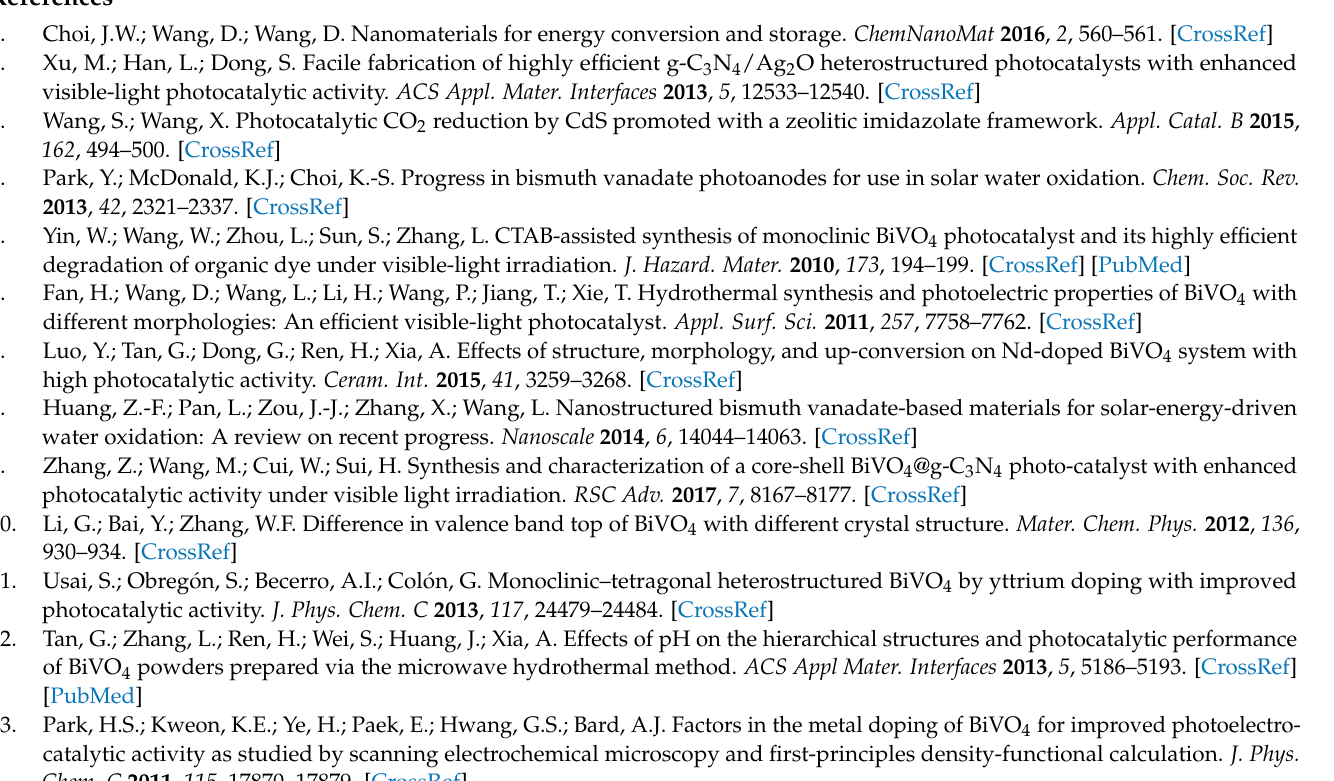
Figure S2: Under visible light irradiation, the removal rate of MB with different concentrations of 1.0-CN/BVO; check the photolysis of MB in the absence of the catalyst, Figure S3: Trapping experiments of active species during the photocatalytic degradation of MB over 1.0-CN/BVO sample under visible light irradiation, Table S1: The photocatalytic performance and catalytic efficiency were compared with other C 3 N 4 , BiVO 4 , and C 3 N 4 /BiVO 4